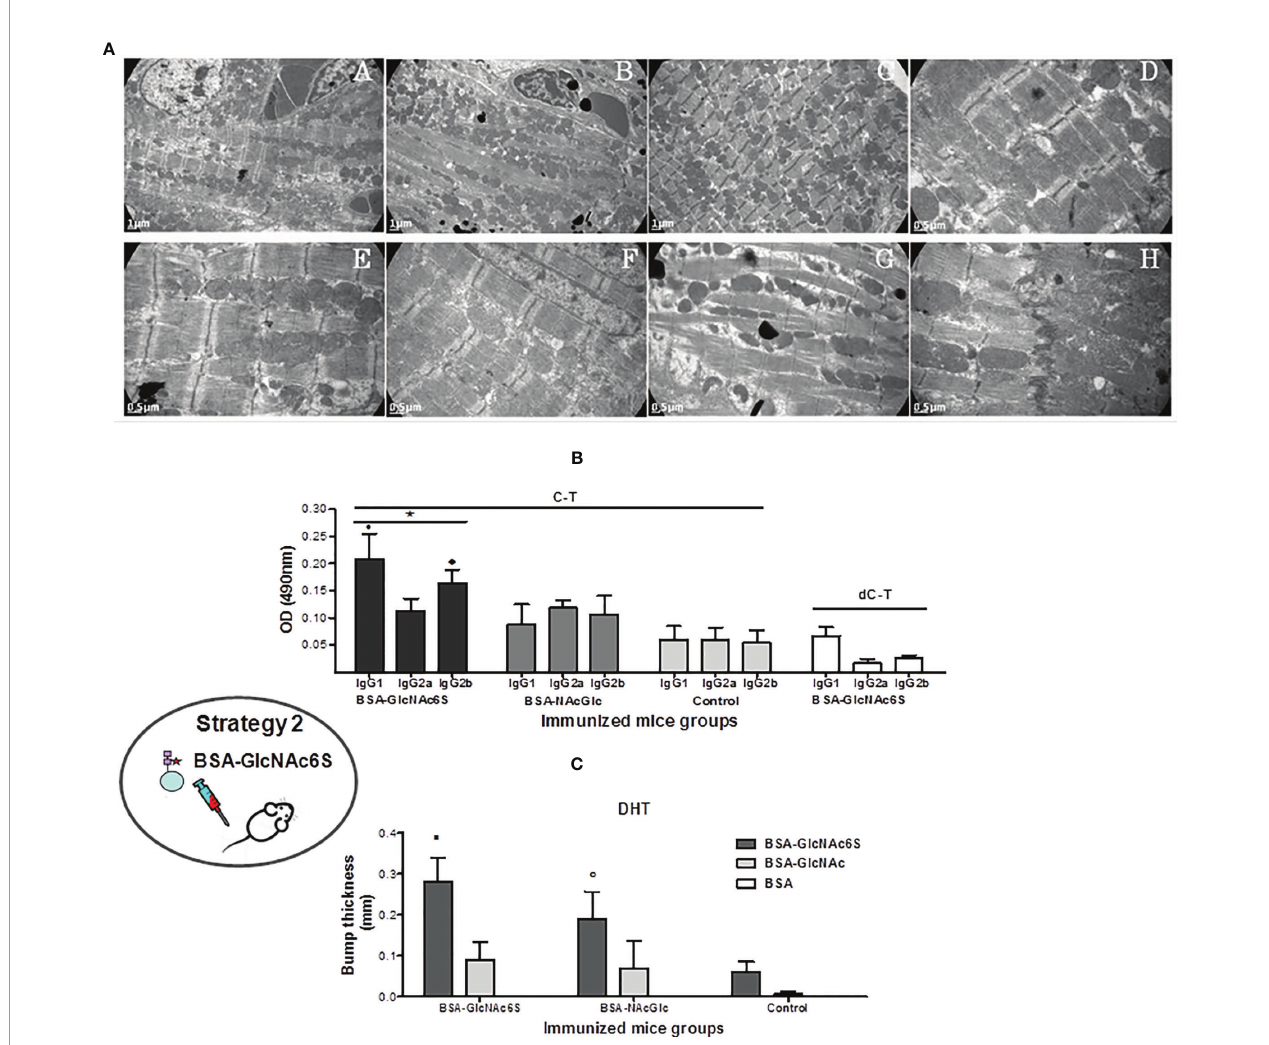
FIGURE 4 | Immunization of BALB/c mice with GlcNAc6S-BSA in the absence of infection. (A) Ultrastructural analysis of cardiac tissue of BSA-GlcNAc6S IM , BSA-GlcNAc IM , and BSA-Phy-Sol IM . Cardiac muscle BSA-GlcNAc6S IM showing severe abnormalities (C) in comparison with normal controls BSA-PhySol (A) and BSA-GlcNAc (B) by transmission electron-microscopy. Magni fi cation of muscle tissue longitudinal sections (7000 ×). At a major magni fi cation, ultrastructural alterations were evidenced in a section of BSA-GlcNAc6S IM [20000 × (D, H)12,000 × (G)], in comparison with the micrograph corresponding to BSA-GlcNAc IM (F) with slight changes and to the normal structure in the BSA-PhySol control mice (E). Determination of immune response to synthetic GlcNAc6S. (B) Humoral immune response in BSA-GlcNAc6S IM . Isotype pro fi le levels in BSA-GlcNAc6S IM and BSA-GlcNAc IM by indirect ELISA, using C-T and dC-T as plate antigens. Control mice were immunized with BSA-IFA. The bars represent the average of the determinations by duplicates and their SD. Black bars, dark grey bars, and light grey bars represent BSA-GlcNAc6S IM , BSA-GlcNAc IM , and BSA, respectively, on C-T antigen. White bars represent BSA-GlcNAc6S on dC-T antigen. (cid:129) p = 0.0079 vs. IgG2a in BSA-NAcGlc6S IM ; p = 0.0079 vs. IgG1 in BSA-GlcNAc IM ; ♦ p = 0.0159 vs. IgG2b from BSA-GlcNAc IM . *C-T vs. dC-T in plate: p = 0.0079 IgG1 (C-T) vs. IgG1 (dC-T); p = 0.0119 IgG2a (C-T) vs. IgG2a (dC-T); p = 0.0079 IgG2b (C-T) vs. IgG2b (dC-T). (C) T-dependent cellular response obtained with GlcNAc6S. Delayed type hypersensitivity (DTH) was measured in dorsal metatarsal hind-limb of control (BSA IM ) ( n = 5), BSA-GlcNAc6S IM ( n = 5), and BSA- GlcNAc IM ( n = 5), 24 and 48 h after intradermal inoculation of BSA-GlcNAc6S( ID ), BSA-GlcNAc ( ID ), and BSA ( ID ). The bars represent the average of the dorsal metatarsal hind-limb indurations thick with their SD. Dark grey bars, light grey bars, and white bars represent BSA-GlcNAc6S (ID) , BSA-GlcNAc (ID) , and BSA (ID) intradermic antigen, respectively. ▪ p = 0.0079 vs. BSA-GlcNAc ( ID ) in BSA-GlcNAc6S IM ; ○ p = 0.0357 vs. BSA-GlcNAc6S ( ID ) in control mice. The oval scheme in the left part of the fi gure represents strategy